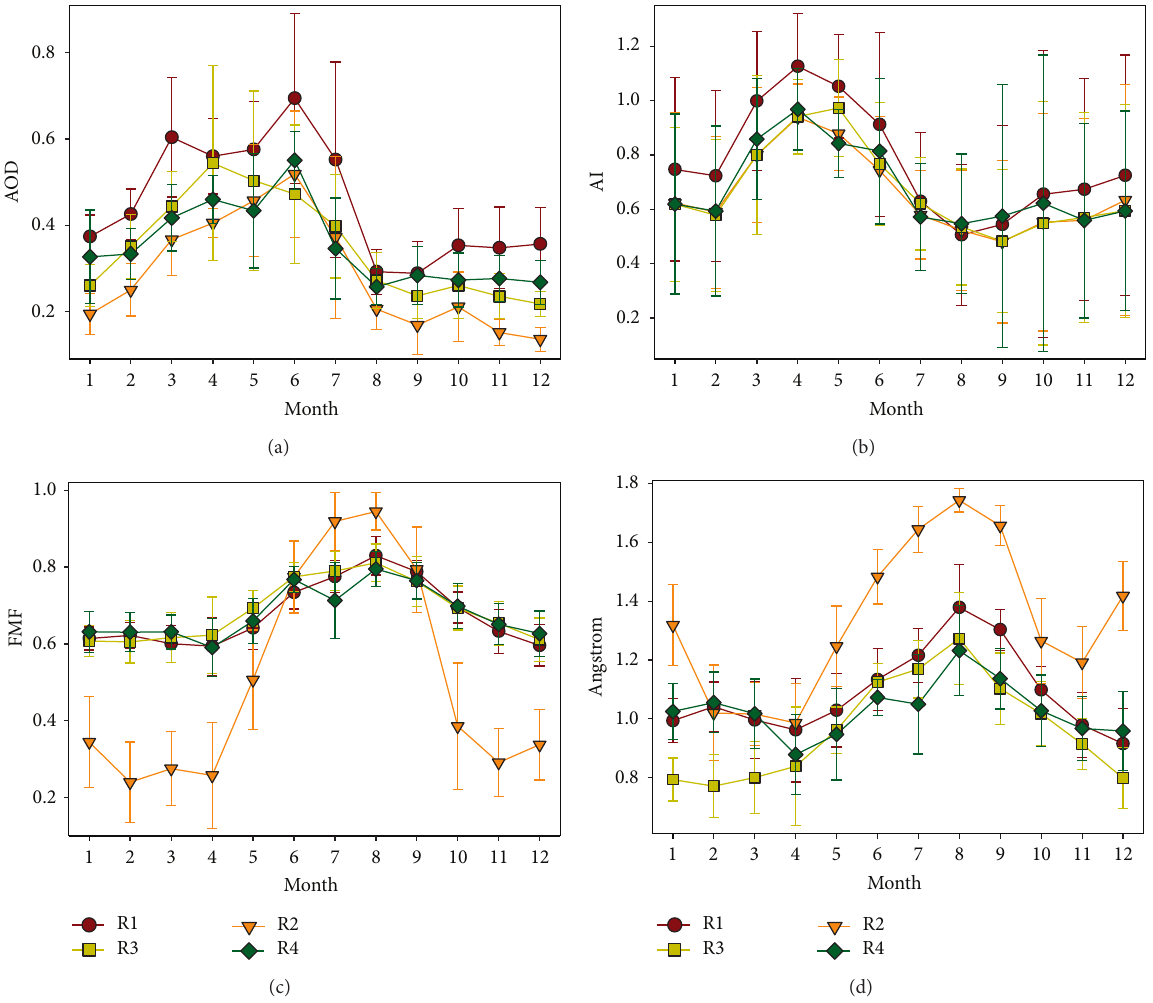
Figure 2: Monthly variability of (a) AOD, (b) AI (c) FMF and (d) Angstrom in R1 (red circle), R2 (orange inverted triangle), R3 (yellow square), and R4 (green